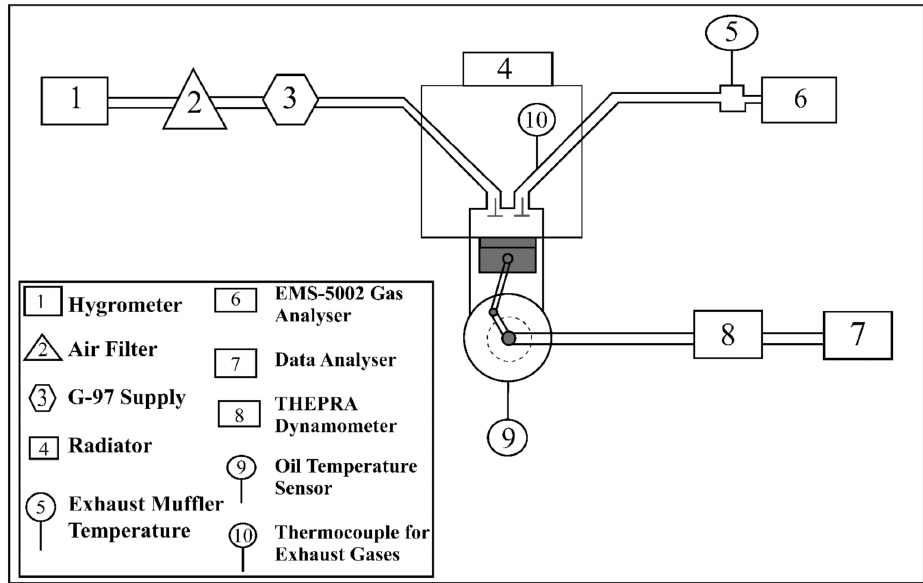
Figure 2. Experimental setup.